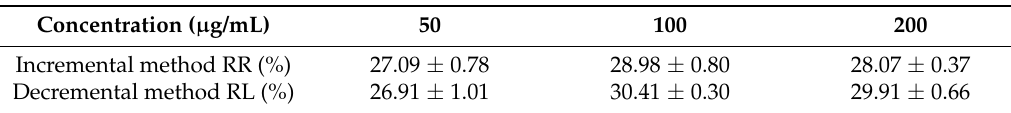
Table 2. Effects of GE concentrations on the in vitro recovery by gain and by loss from the knee-joint microdialysis probes in vitro ( n = 4, x ± s ).